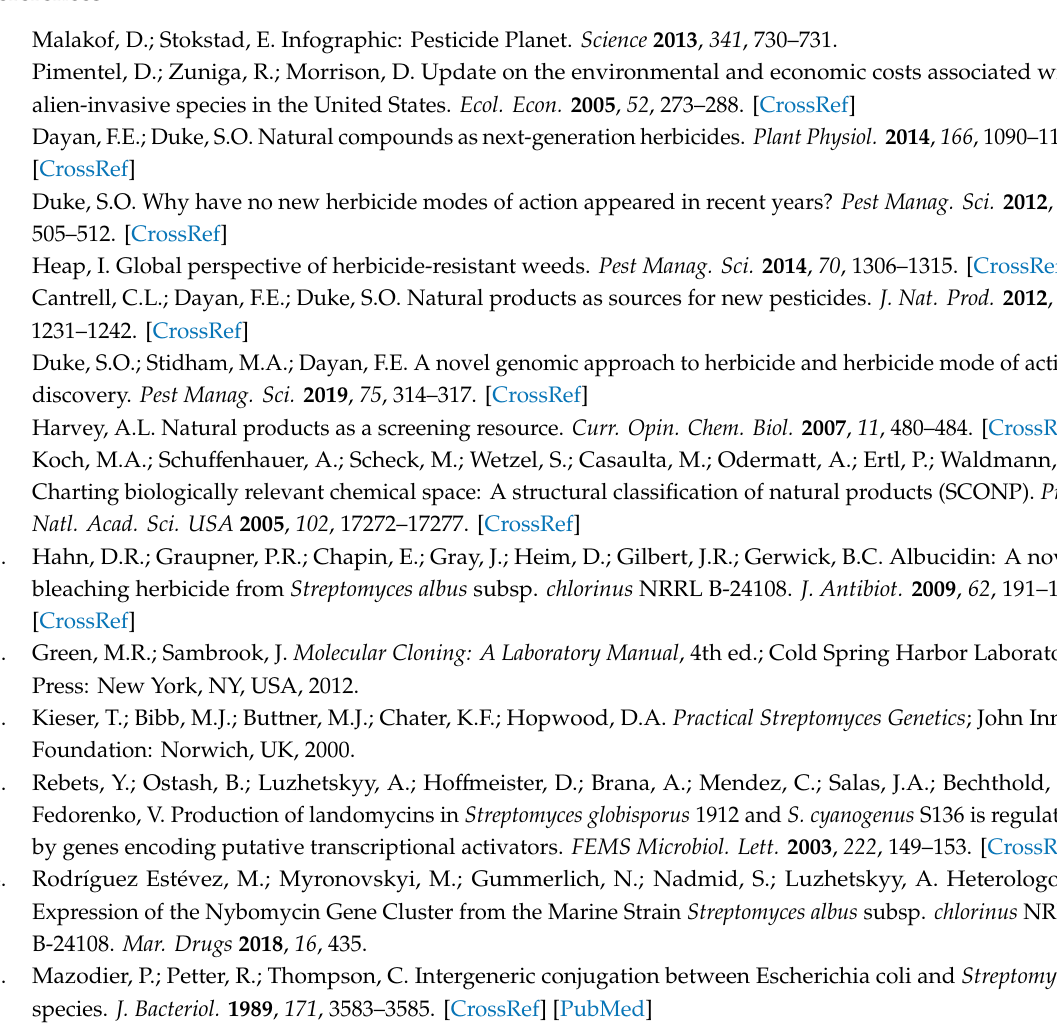
Figure S1: 1 H NMR spectrum of albucidin (500 MHz), Figure S2: The genes albA and albB with the mapped point mutations identified in the course of NTG-mutagenesis, Figure S3: High resolution HPLC-MS analysis of albucidin production by Streptomyces albus 1K1, Figure S4: HPLC-MS analysis of albucidin production by Streptomyces albus strain harboring 1K1 BAC and its derivatives with gene deletions, Figure S5: HPLC-MS analysis of albucidin production by Streptomyces albus 1K1 BAC ( a ) and Streptomyces albus 2D4 BAC ( b ), Figure S6: HPLC-MS analysis of albucidin production by Streptomyces albus strain harboring 1K1 BAC and its derivatives with gene deletions, Figure S7: HPLC-MS analysis of albucidin production by Streptomyces albus strain harboring full length 1K1 BAC ( a ) and minimized 1K1_alb_act BAC, containing only transcriptionally activated albA–C operon ( b ), Table S1: Bacterial strains used in the study, Table S2: Plasmids and BACs used in the study, Table S3: Primers used in this study. References [26,27] are cite d in the supplementary